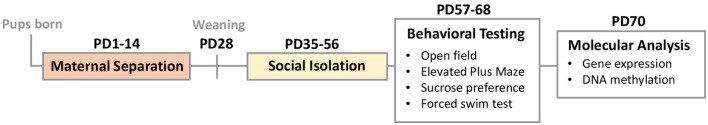
Study design: two stress hits included early-life maternal separation (MS, PD1–14) and adolescent social isolation (SI, PD35–56). This design generated four groups of animals: no stress controls (CON), MS only, SI only, and combined two-hit stress MS_SI group. The majority of animals underwent behavioral testing from PD57–68 and their non-tested littermates were sacrificed for molecular analyses of the ventral hippocampus at PD70.